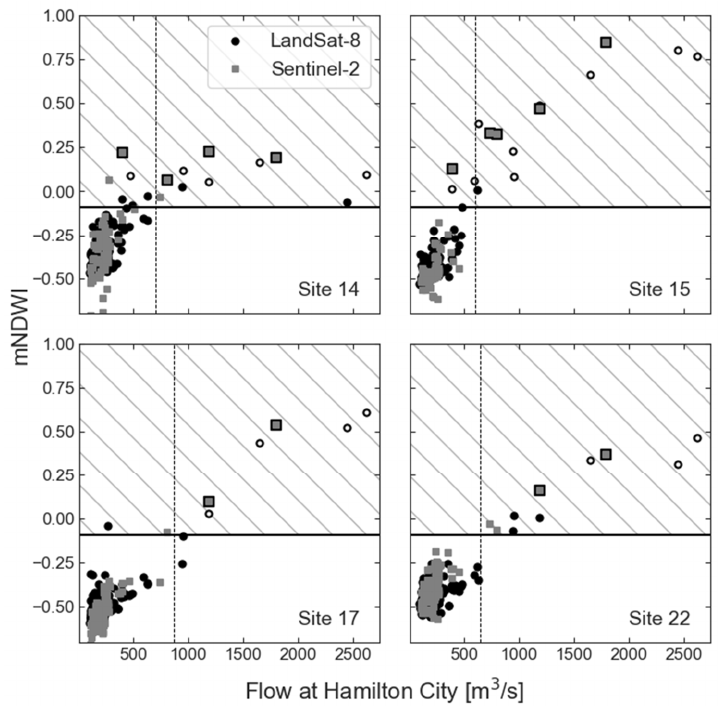
Figure 2. Computed mNDWI values for surveyed off-channel habitats (Table 3) reported in [18] and existing daily Sacramento River flows recorded at Hamilton City (HMC). The hashed area indicates inundated conditions at the site. The vertical dashed line indicates required Sacramento River flows for off-channel activation [18]. Highlighted points represent dates when both single threshold and dynamic threshold identified the location as inundated.